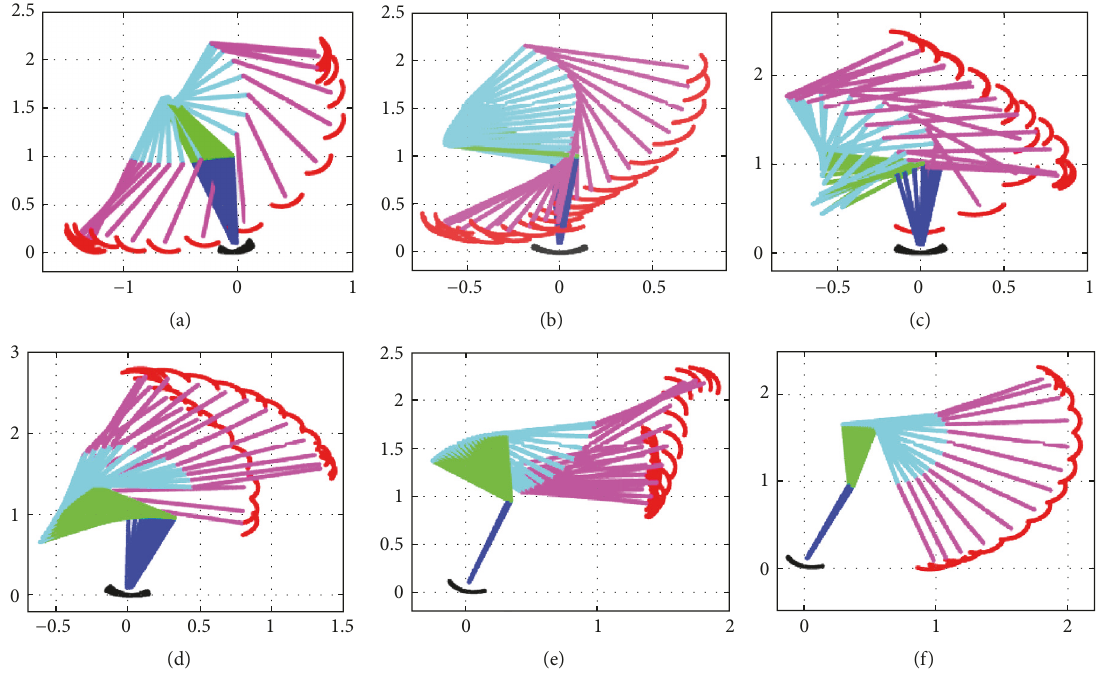
Figure 19: Motion description of AR. (a) From 0s to 0.2s. (b) From 0.2 s to 0.4s. (c) From 0.4s to 0.6s. (d) From 0.6 s to 0.8 s. (e) From 0.8s to 1s. (f) From 1s to 1.12s.